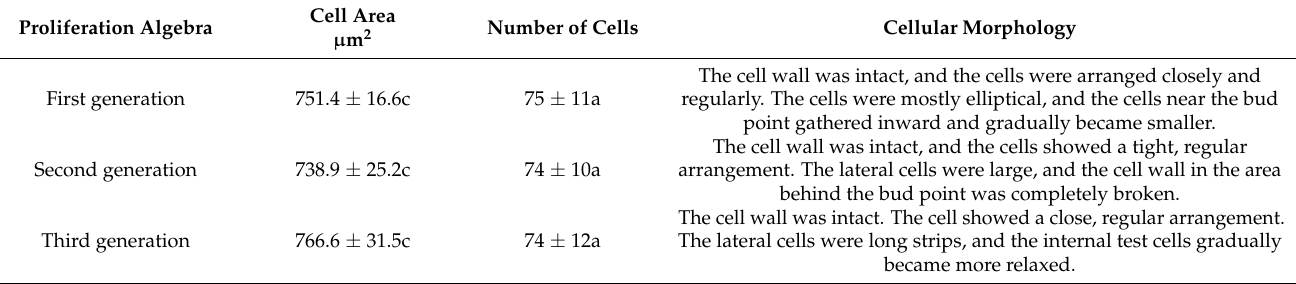
Table 6. Morphological data of callus cells in different